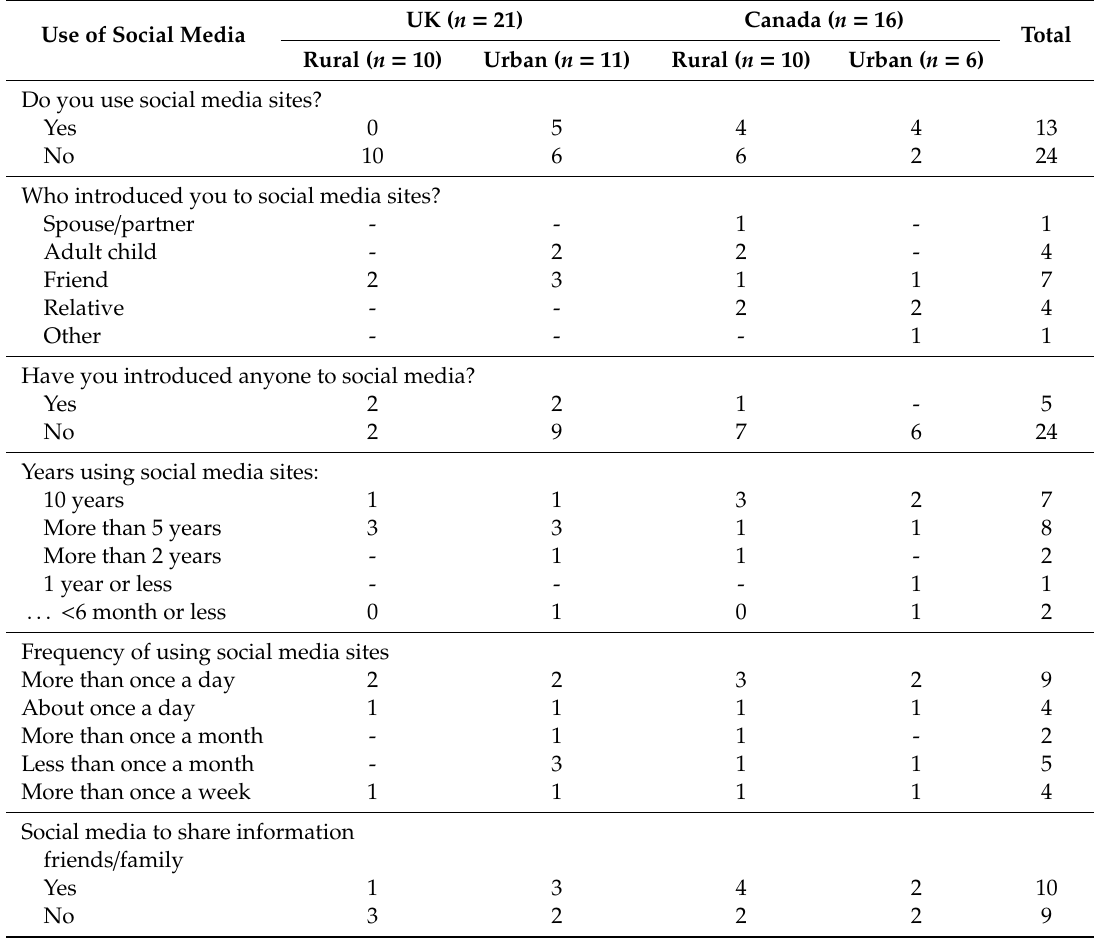
Table 4. Social media use by country (UK and Canada) and location (rural and